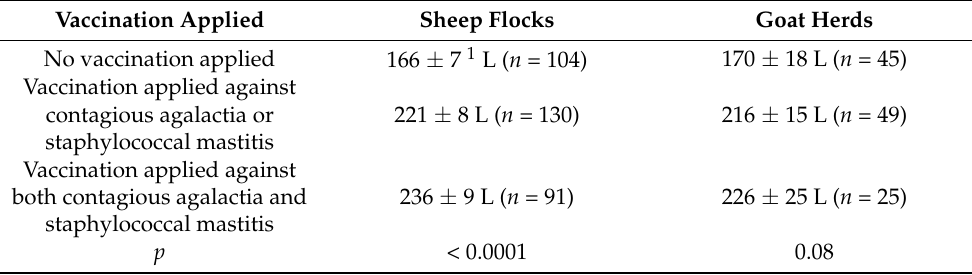
Table 3. Association of vaccination against contagious agalactia or staphylococcal mastitis with average milk production per animal in small ruminant farms in Greece.